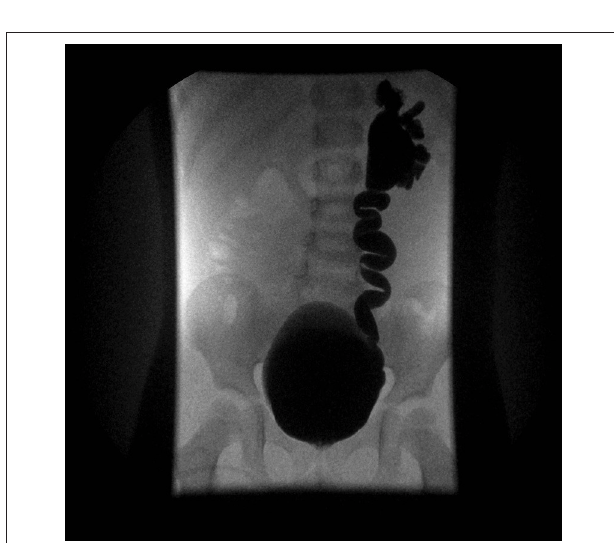
FIGURE 3 | VCUG image of primary vesicoureteral reflux grade